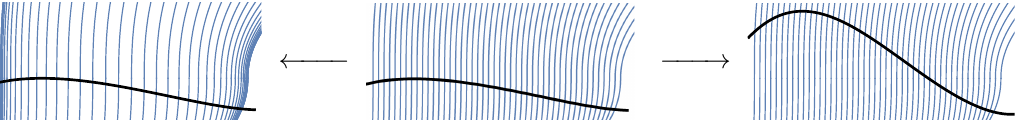
←−−− −−−→ Figure 3. Given the bundle M (cid:16) ¯ M , any bundle automorphism maps ¯ M to itself smoothly, but generally shuffles its points so that different fibres are mapped on one another (left). Furthermore, automorphisms locally change the origin of the Carrollian time coordinate (right). They also affect the local normalisation of the fundamental vector field (not shown here). In the BMS context, local translations along fibres are supertranslations, while superrotations are automorphisms projecting onto conformal maps of the base space: see sections